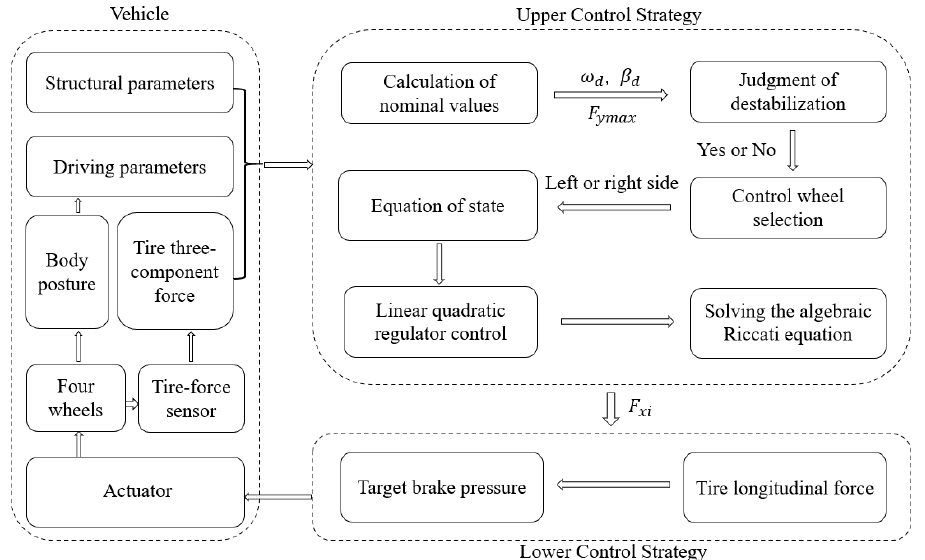
Figure 3. Controller system structure.